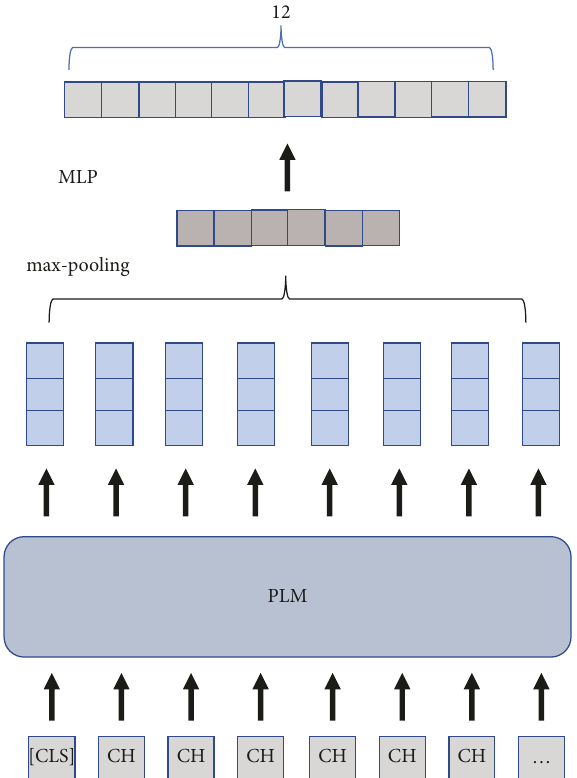
Figure 2: Structure chart of policy instrument classification model.